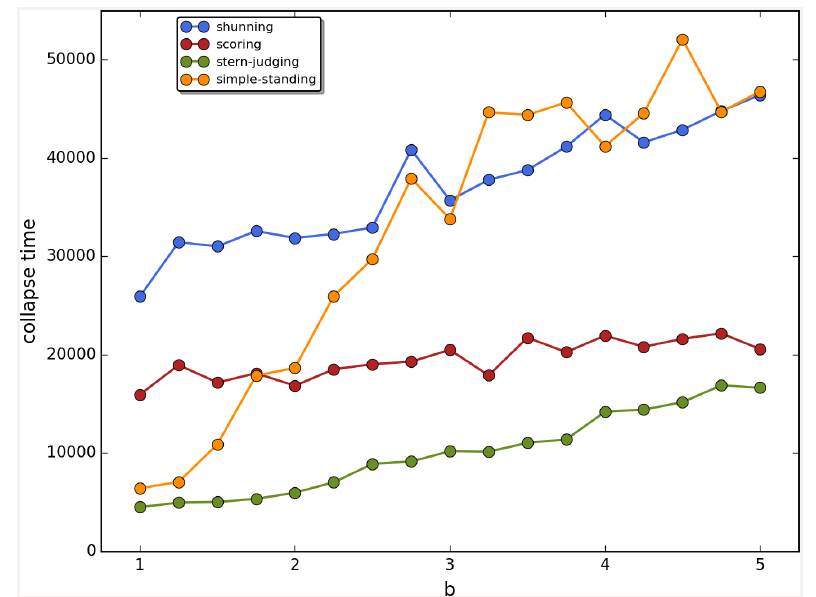
Fig 5. The average time elapsed till the collapse of cooperation, MST90. The figure shows the average time until the collapse of cooperation as a function of the value of the benefit ( b ) for different social norms in the second scenario (MST90). Each symbol represents the average of 100 runs, parameters are as follows: n = 100, c = 1, α = 1, β = 4, MST =